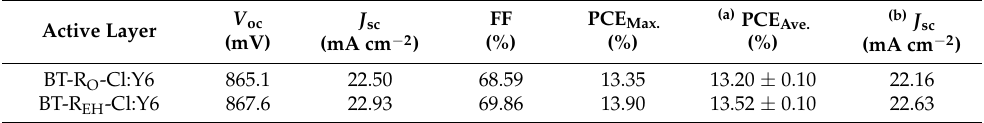
Table 2. Photovoltaic parameters for the best BT-R O -Cl:Y6 and BT-R EH -Cl:Y6 devices. Active Layer